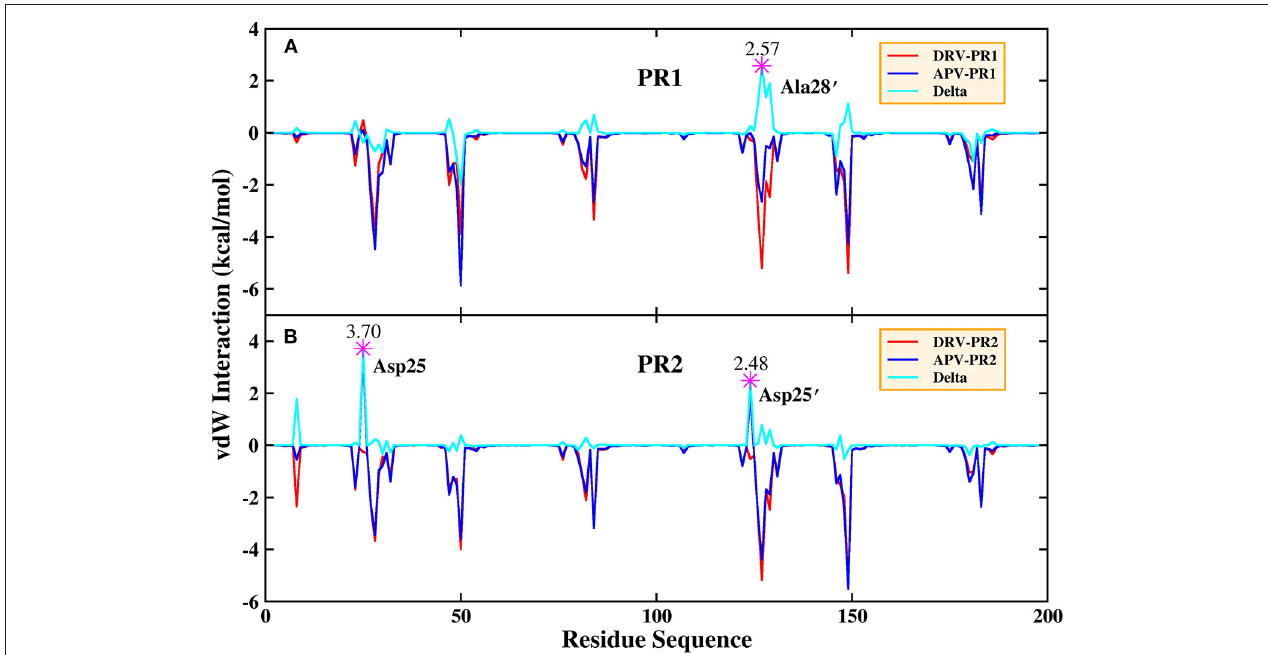
FIGURE 5 | Decomposition of residue based on vdW interaction. (A) PR1 complexes. (B) PR2 complexes.